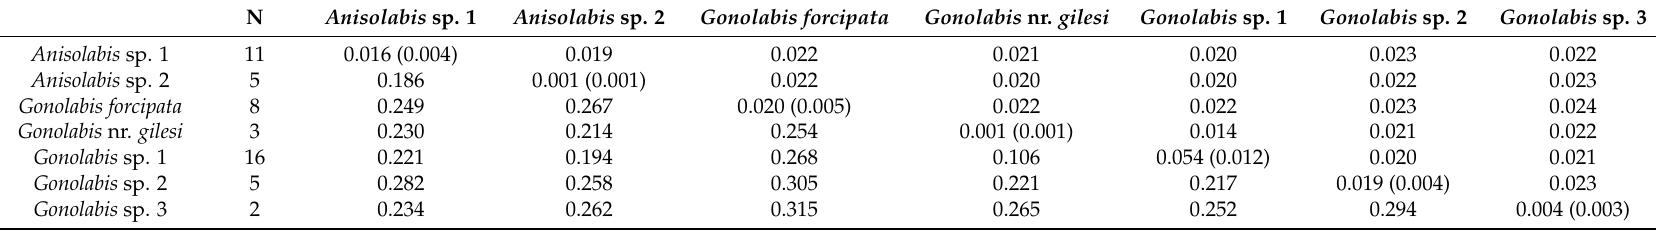
Table 3. Uncorrected p-distances within and between Anisolabididae morphospecies cytochrome b sequences (358 bp). Interspecific means and variances are shown on the left and right of the diagonal. Intraspecific mean shown on diagonal with variance in brackets. Variances were calculated using 1000 bootstraps. N refers to number of individuals of morphospecies